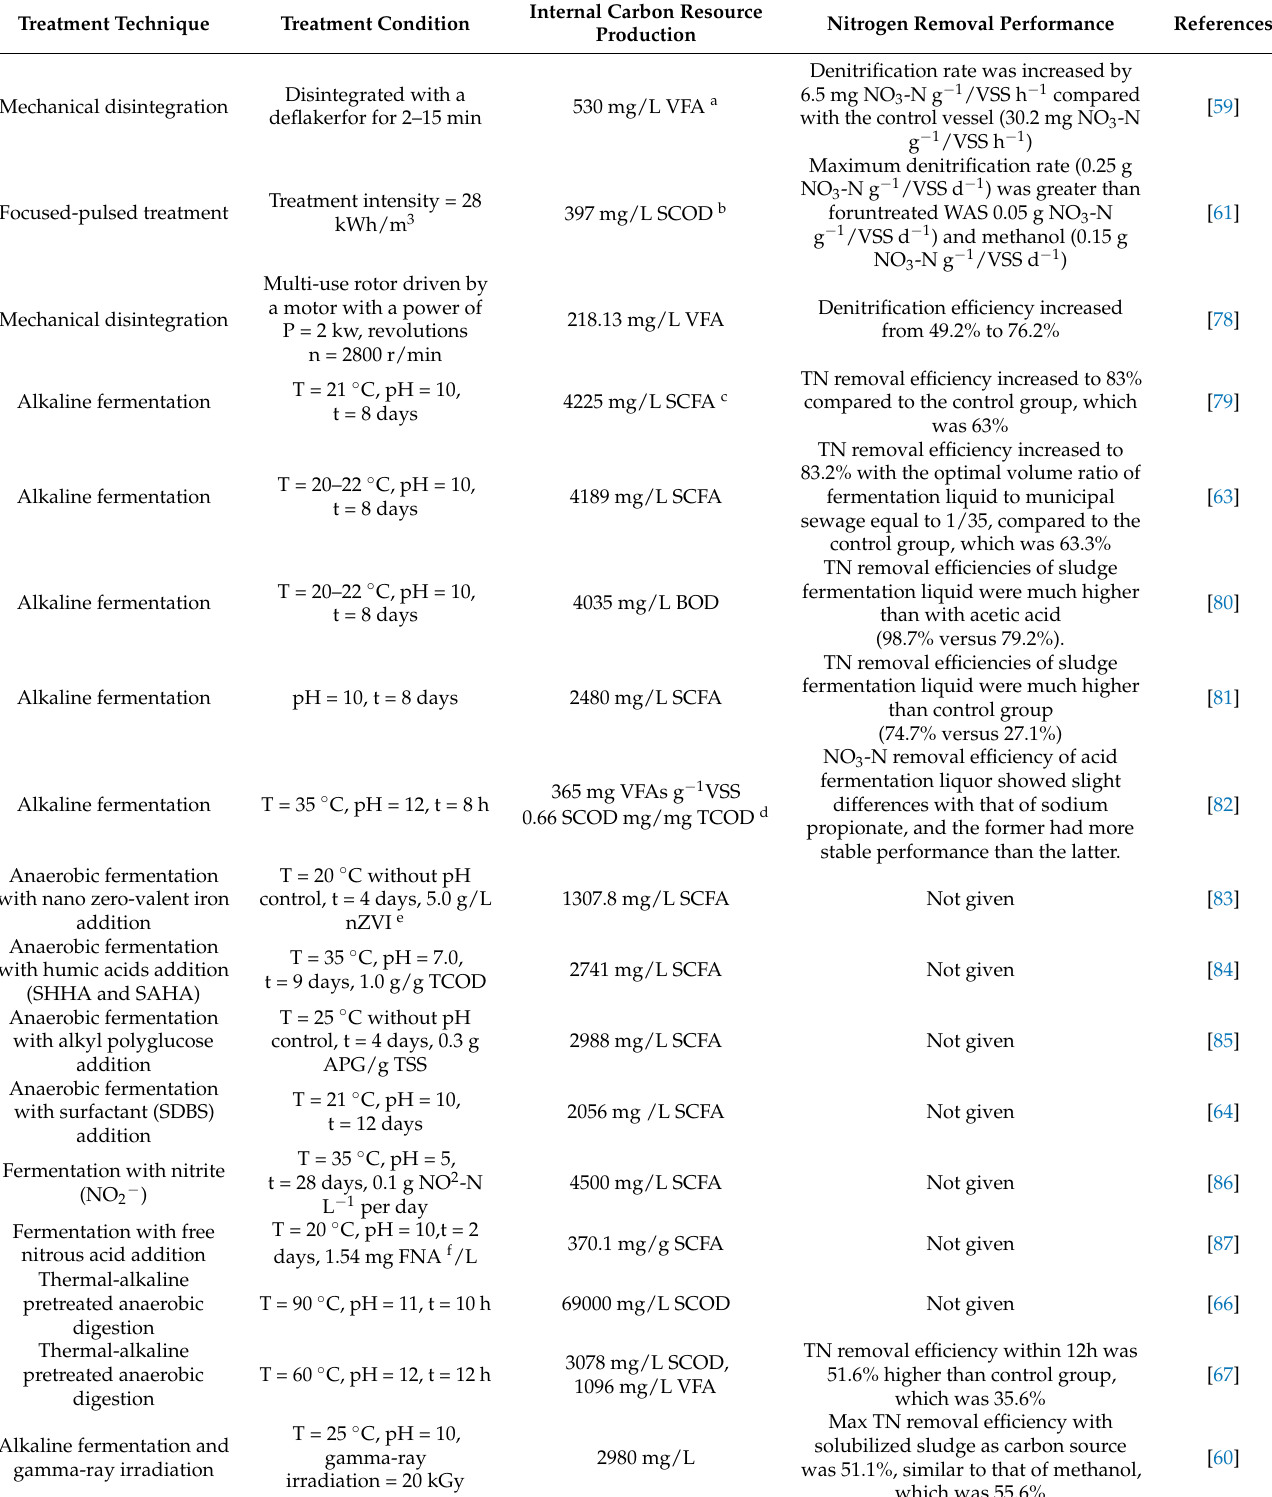
Table 3. Internal carbon source production of waste-activated sludge under different treatment